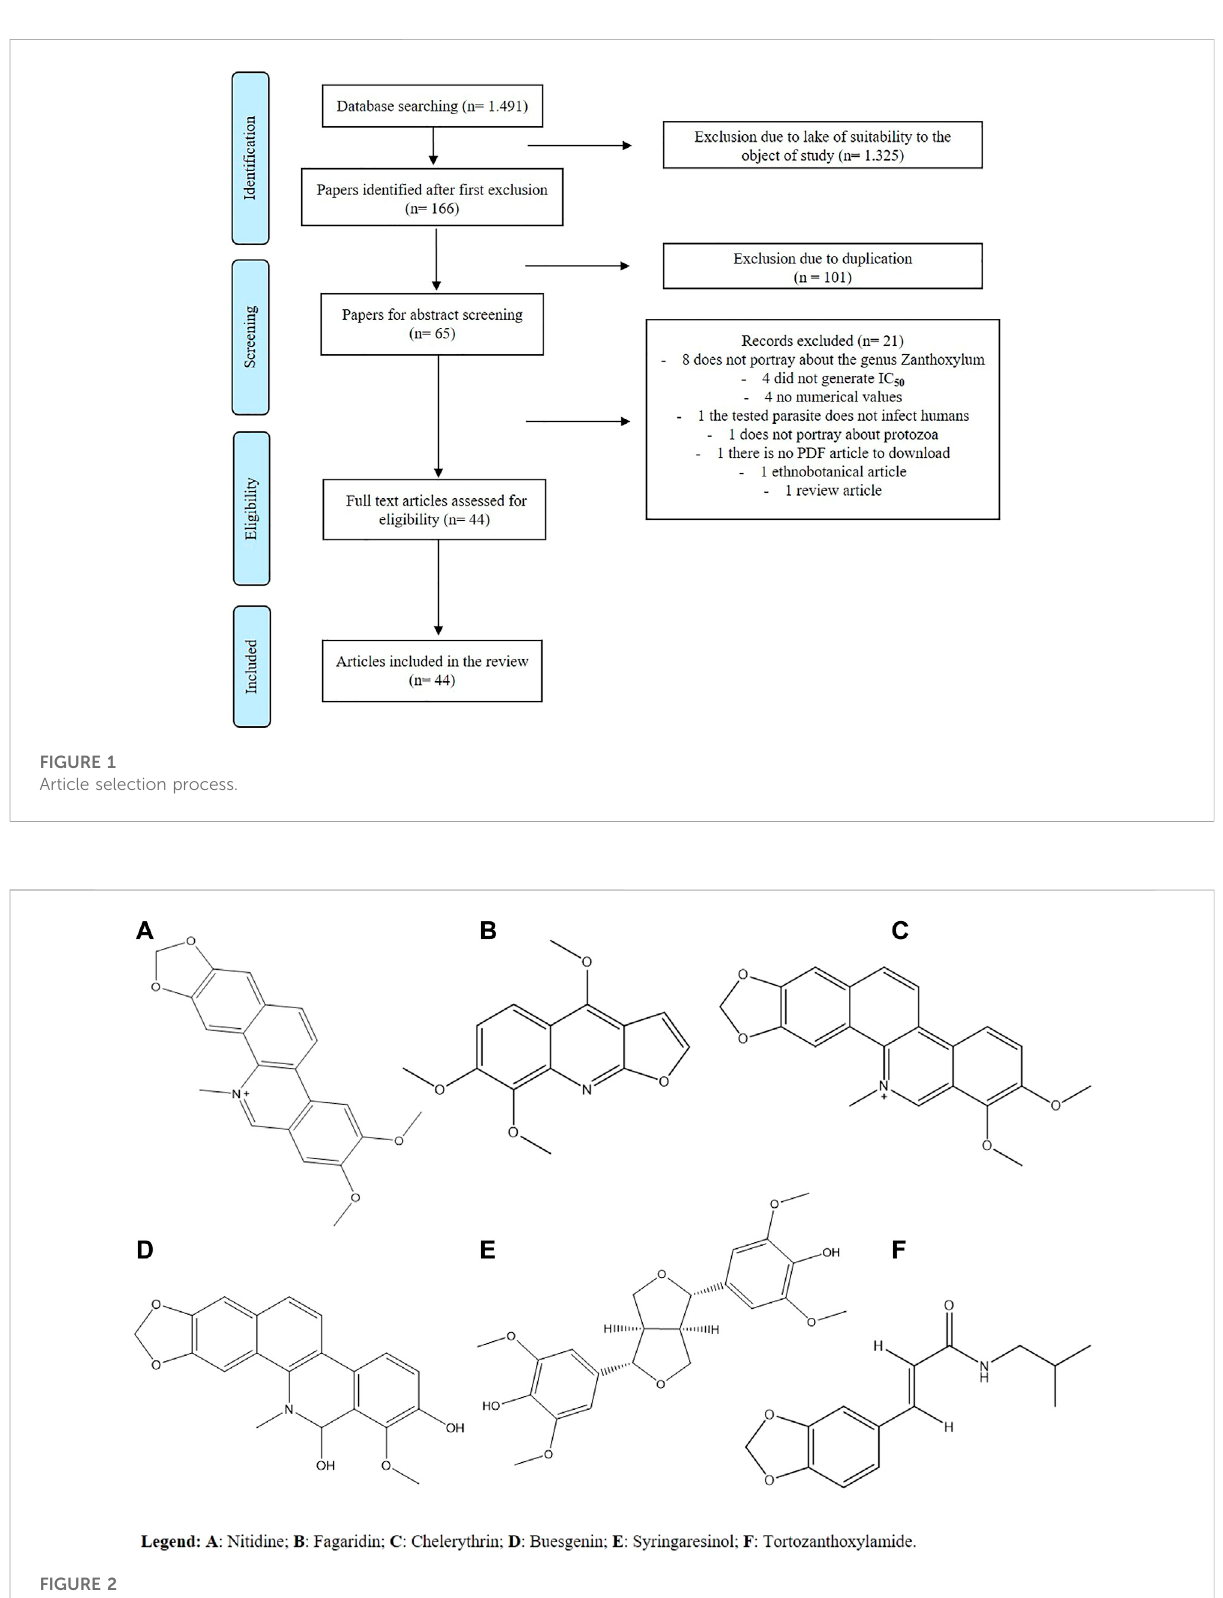
FIGURE 2 Most promising secondary metabolites for the diseases